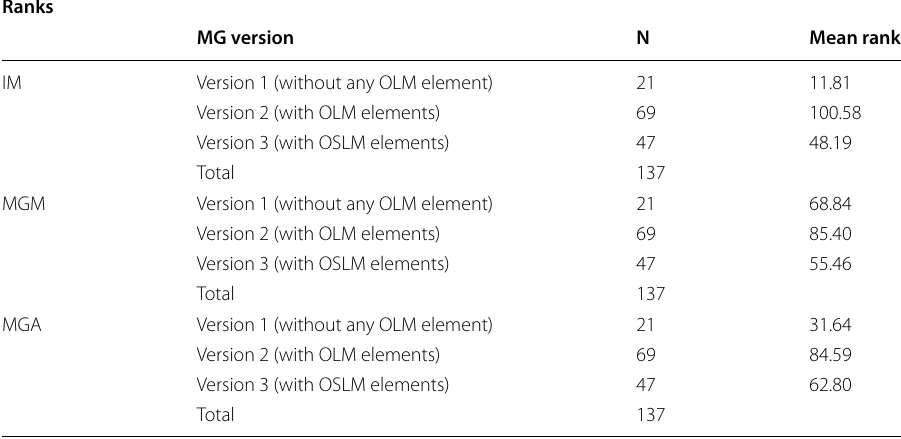
Table 6 Test statistics [Kruskal Wallis Test—Grouping Variable: MG version] Ranks MG version N IM